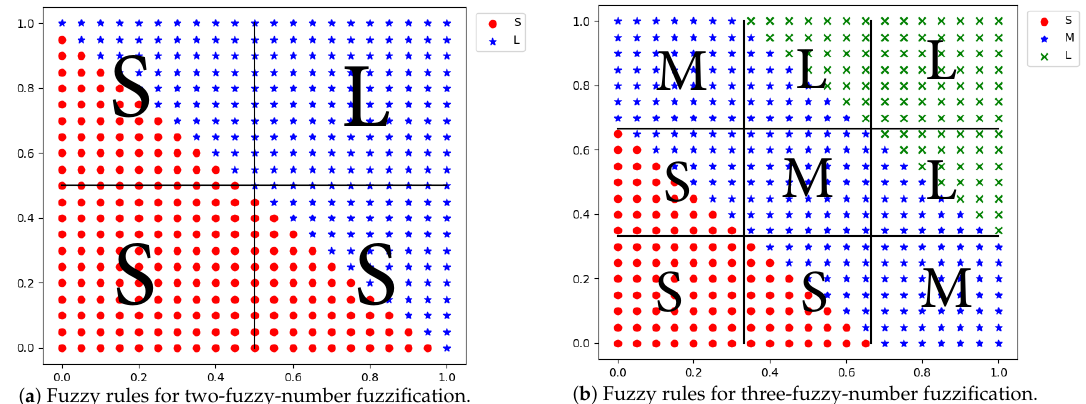
Figure 8. Data distributions and generated fuzzy rules on the linear function data